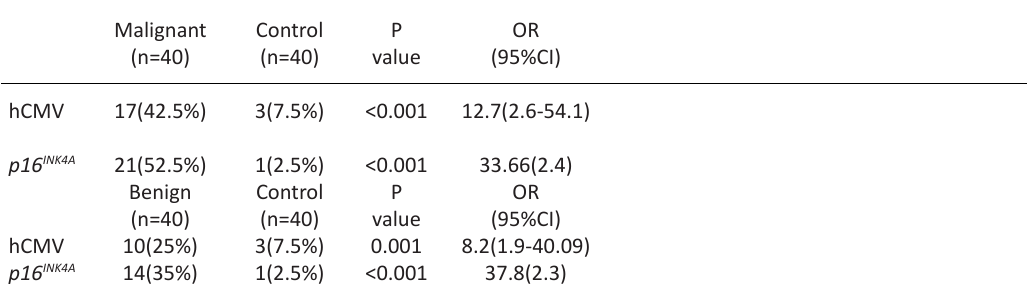
Table 3. The Association Between HCMV and P16 INK4A With Malignant And Benign Oral Squamous Cell Tissues